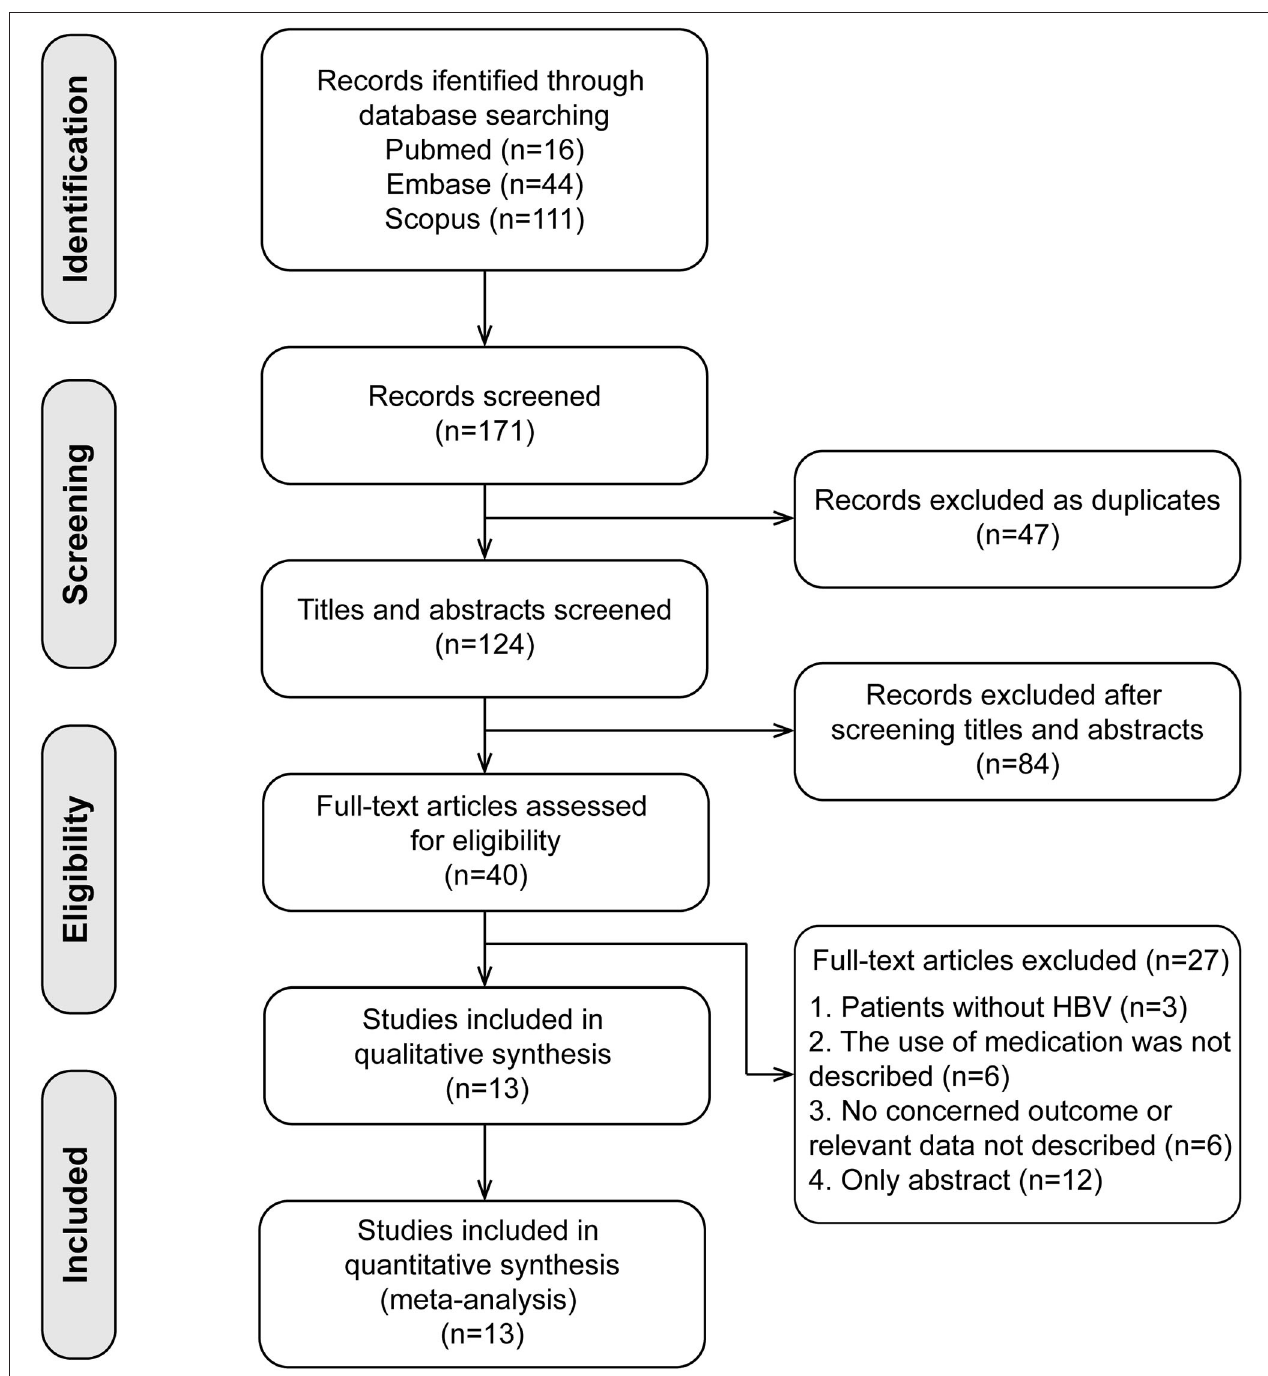
FIGURE 1 | Flow chart of research selection process. Thirteen cohort studies were included in the present meta-analysis.